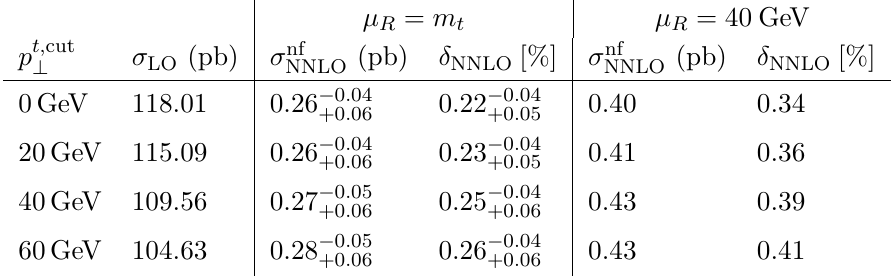
Table 1. Dependence of the non-factorisable corrections on the top-quark transverse momentum. The factorisation scale is fixed to µ F = m t . In the third column, the non-factorisable cross sections are evaluated at µ R = m t with sub- and super-scripts indicating the scale variation, m t / 2 and 2 m t respectively. The penultimate column describes the non-factorisable corrections at µ R = 40 GeV . For each scale choice, we report the relative impact, δ NNLO , of the non-factorisable contributions with respect to the LO cross